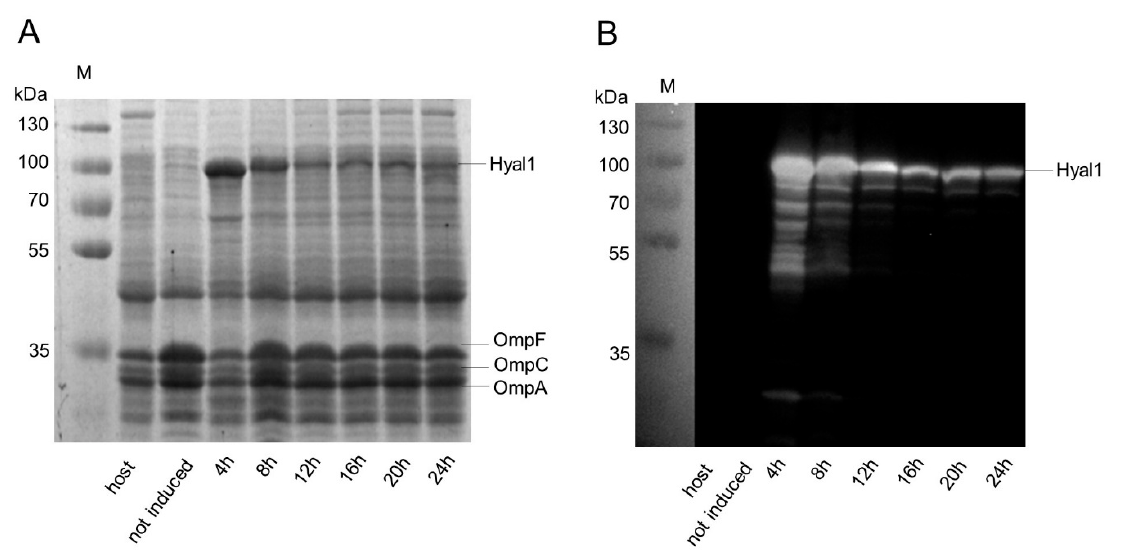
Figure 4. Induction time influences surface expression of Hyal1 on E. coli F470. Analysis of outer membrane protein isolations by 10% SDS-PAGE stained with ProBlue Safe Stain ® ( A ) and Western Blot ( B ) using a primary monoclonal, anti Hyal1 antibody and a secondary HRP-conjugated polyclonal antiserum. Apparent molecular weights of marker proteins are indicated on the left in kDa (M). Outer membrane proteins from E. coli F470 (host) and E. coli F470 carrying pAIDAI rha -Hyal1 with and without the induction of Hyal1 surface display by the addition of 1 mM rhamnose and increasing induction times. Protein samples were standardized by the amount of natural outer membrane proteins occurring, i.e., to show identical band sizes for OmpC, OmpF and OmpA. Hyal1 enzyme activity was determined using a previously described Stains-all assay [42].